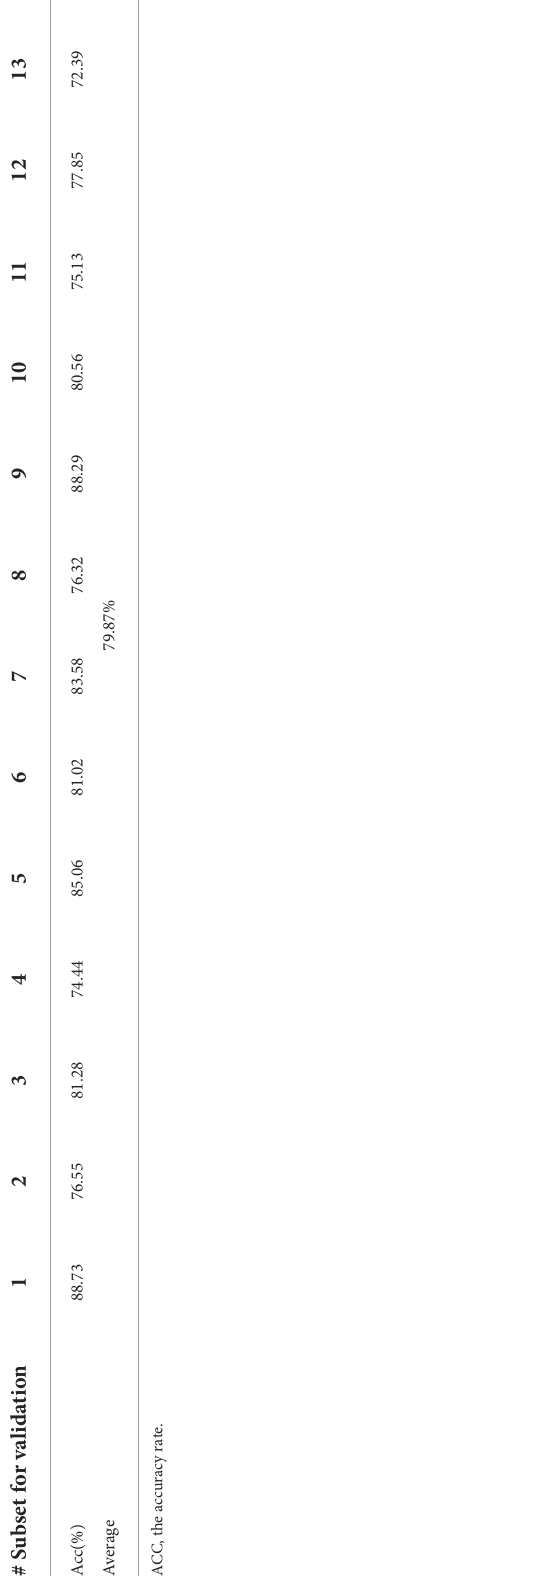
TABLE 4 The nodes and edges involved in the FC features with high overlap rate (12/14) among